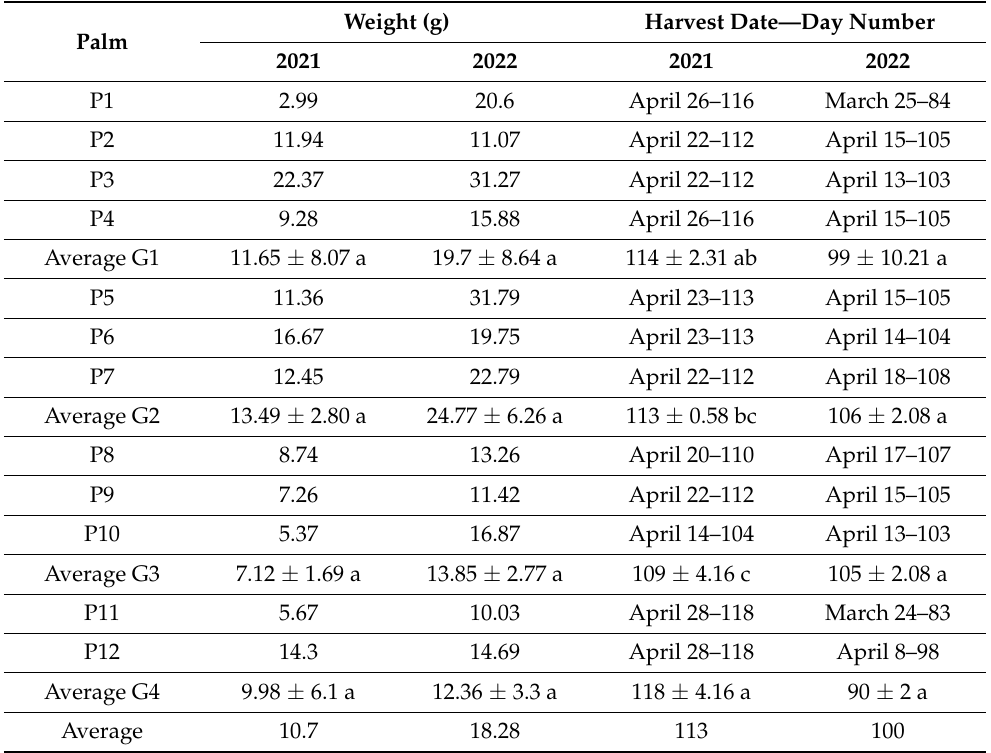
Table 5. Pollen production of the last harvested inflorescence, in each of the twelve seedling date palm males, selected for pollen extraction. Weight (g) Harvest Date—Day Palm